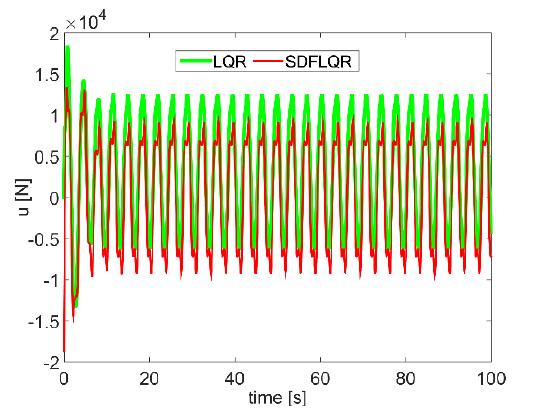
Figure 5. Time history of the applied control force for SDFLQR and